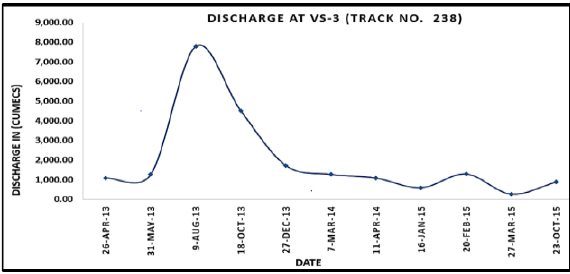
Figure 10. Estimated River discharge (2013-2015) at one of Altika virtual gauge near Tikarpara, Mahanadi River 4.2 Altika based Ice elevation estimation and changes near, Maitri, East Antarctica